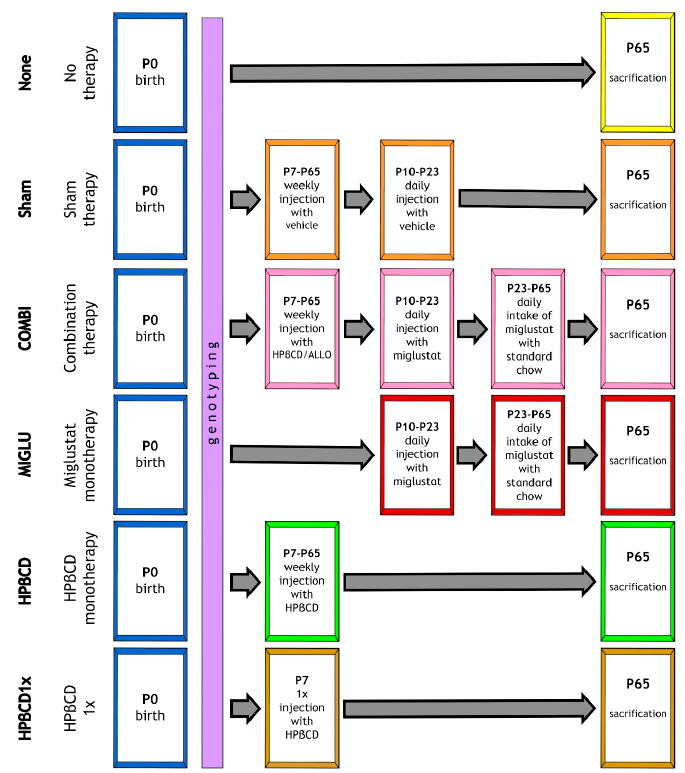
Figure 22. Timeline of drug administrations for all experimental groups. At P7 and thenceforth, Npc1 mice were injected weekly with allopregnanolone (25 mg/kg; Sigma Aldrich, St. Louis, MO, USA) dissolved in HPßCD (4.000 mg/kg, i.p.; Sigma Aldrich). At P10 and until P23, animals were injected daily with miglustat (300 mg/kg, i.p.; Zavesca; Actelion Pharmaceuticals, San Francisco, CA, USA). From P23 onward, animals were fed with miglustat included in standard chow (1.200 mg/kg per day) until termination. Mice of the Sham groups were injected with the respective amounts of 0.9% NaCl according to the treatment plan of the combination-treated group. Abbreviations used for the experimental groups are given in bold on the left side.